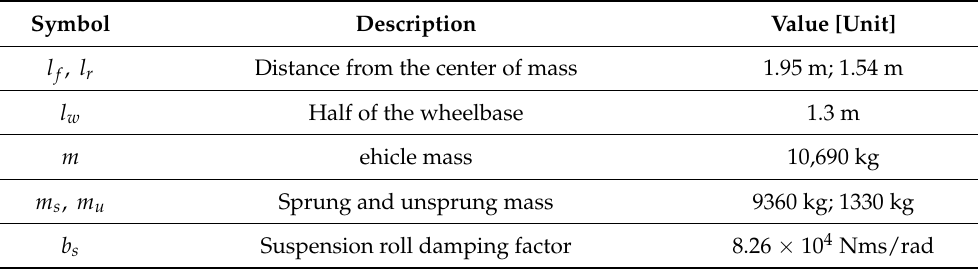
Table 1. The basic parameters of the